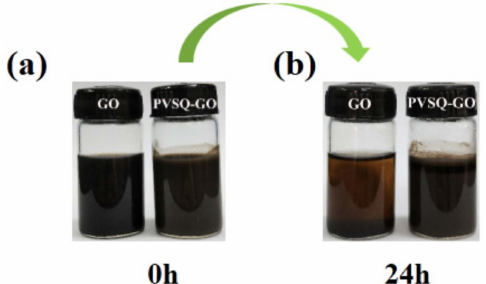
Figure 2. Optical photographs of graphene oxide (GO) and silane functionalized graphene oxide (PVSQ-GO) dispersions after 24 h. ( a ) just ultrasonication for 30 min; ( b ) storage for 24